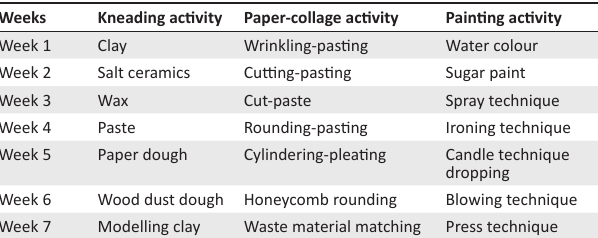
TABLE 1: Weekly art education module.